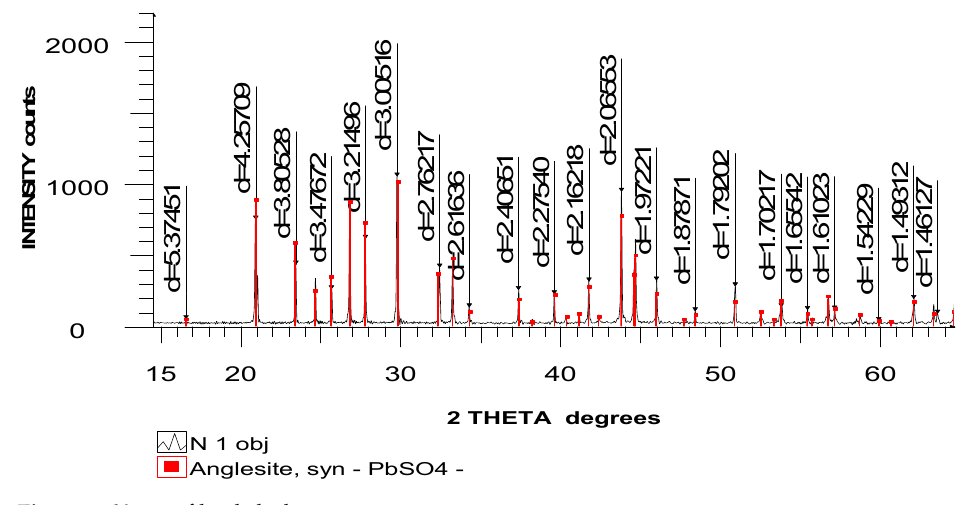
Figure 1. X-ray of lead sludge. Figure 1. X ‐ ray of lead sludge.